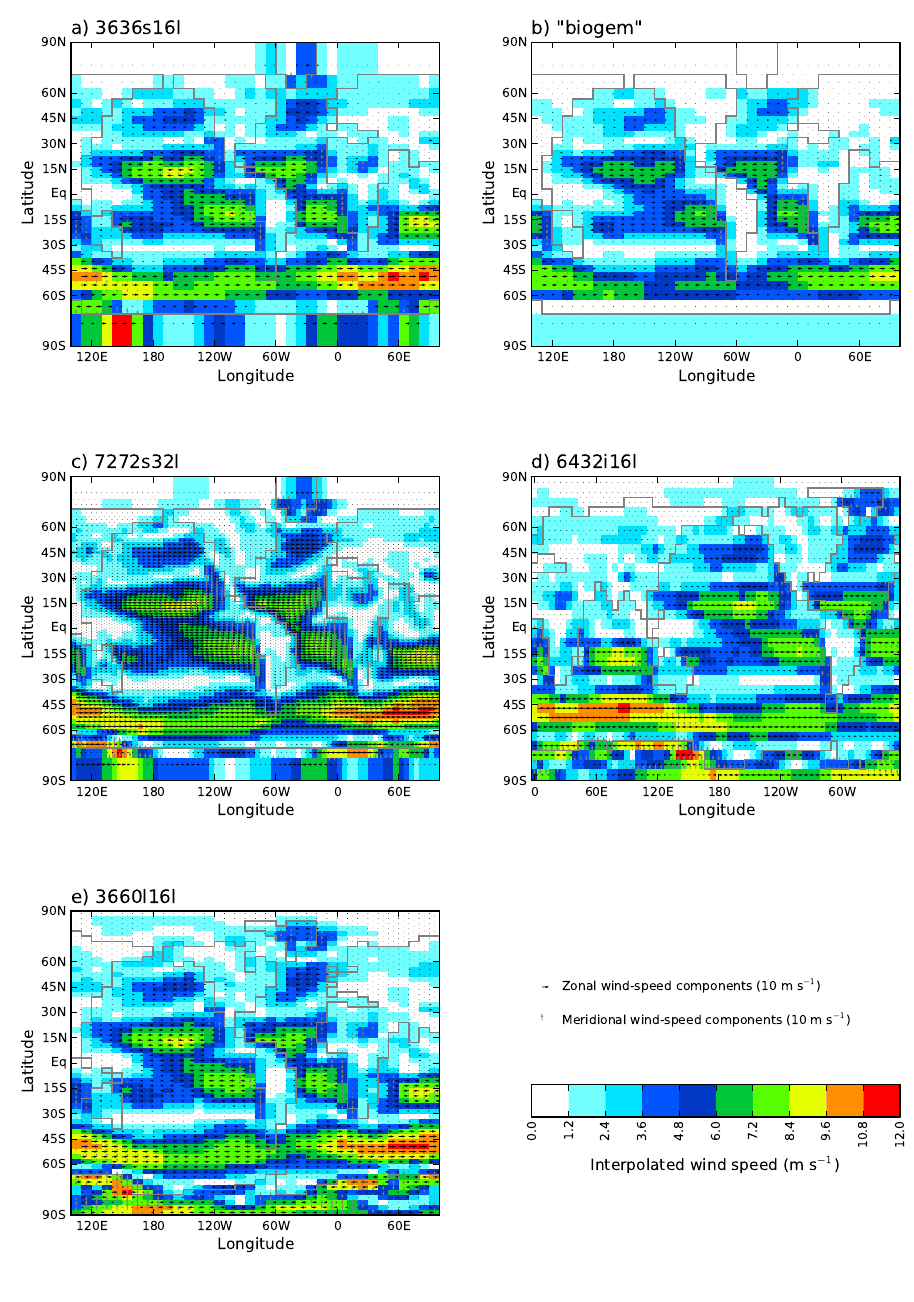
Fig. 3. Annual-mean surface winds (speed and zonal/meridional components), as used in the EMBM, for each configuration.